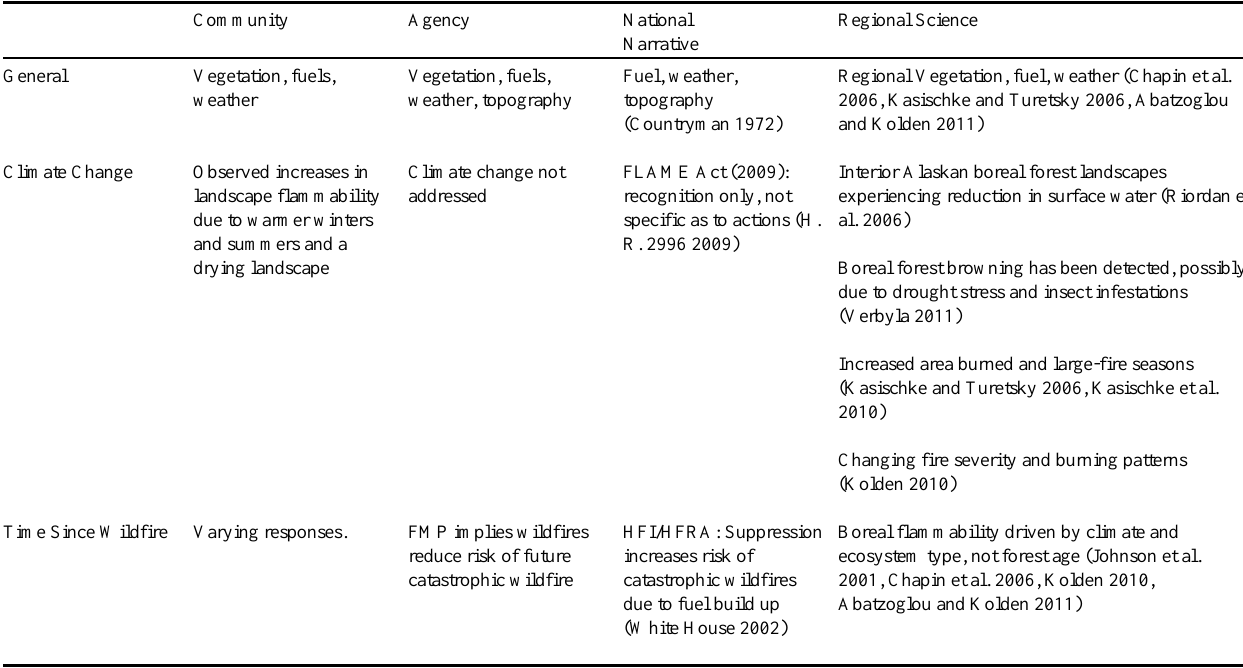
Table 3 . Drivers of